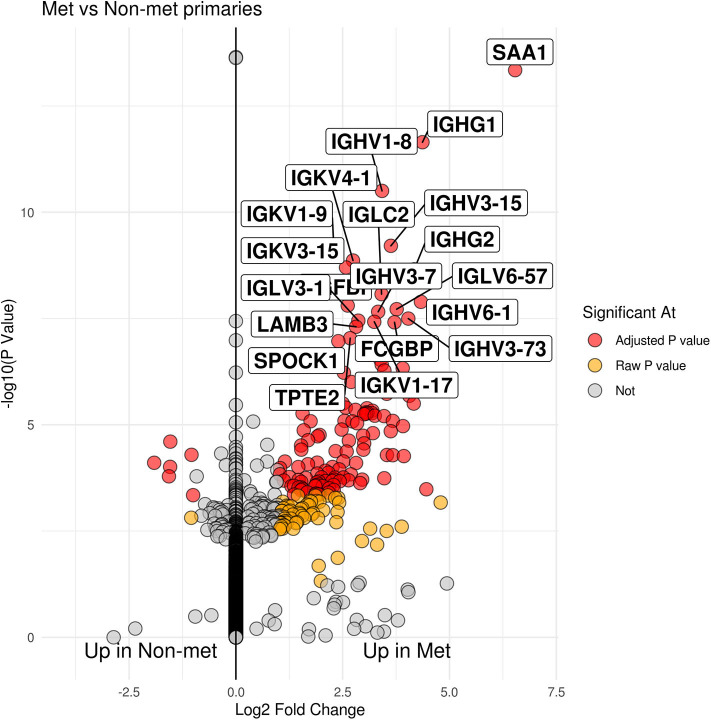
Volcano plot of patients who developed metastases within 5 years vs. those that did not. The x-axis is log 2 fold change between groups while the y-axis is -log 10 raw p-value. The top 20 genes by p-value are labeled.